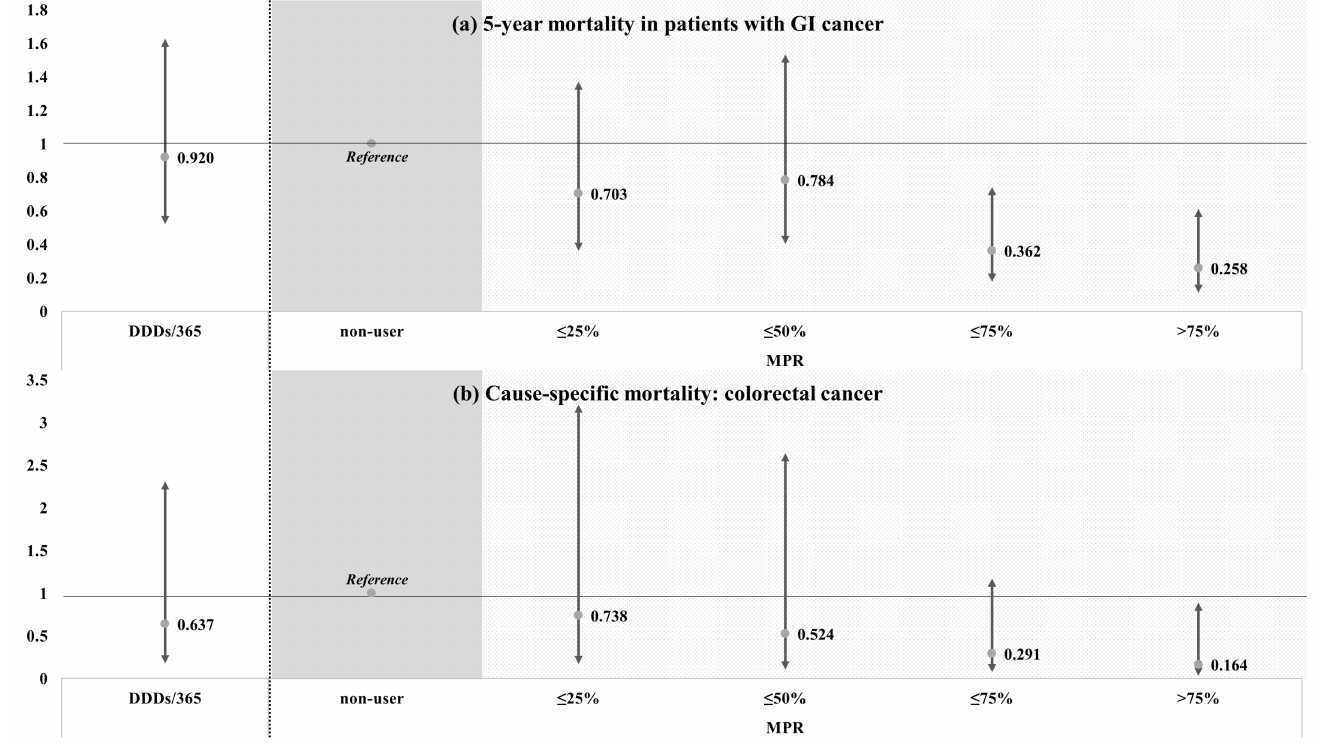
Figure 1. Effect of continued statin use on mortality in GI cancer patients. ( a ) Relationship between continued use of statin and 5-year mortality. ( b ) Relationship between continued use of statins and death from colorectal